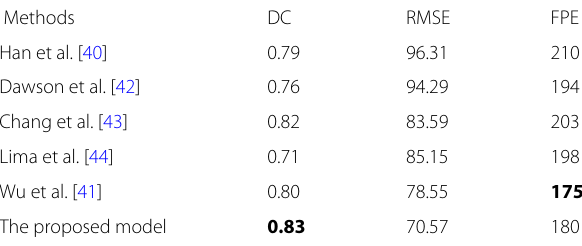
Table 3 Performance comparison with comparative data-driven methods on Changhua dataset. It is noted that we adopt 4000 samples and 6 iterations to train the proposed model